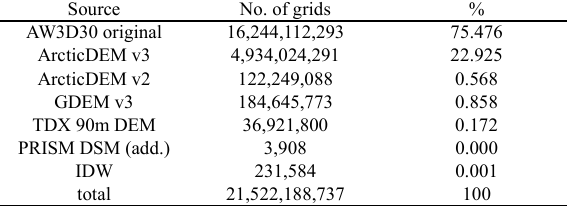
Table 4. Proportion of source data in the